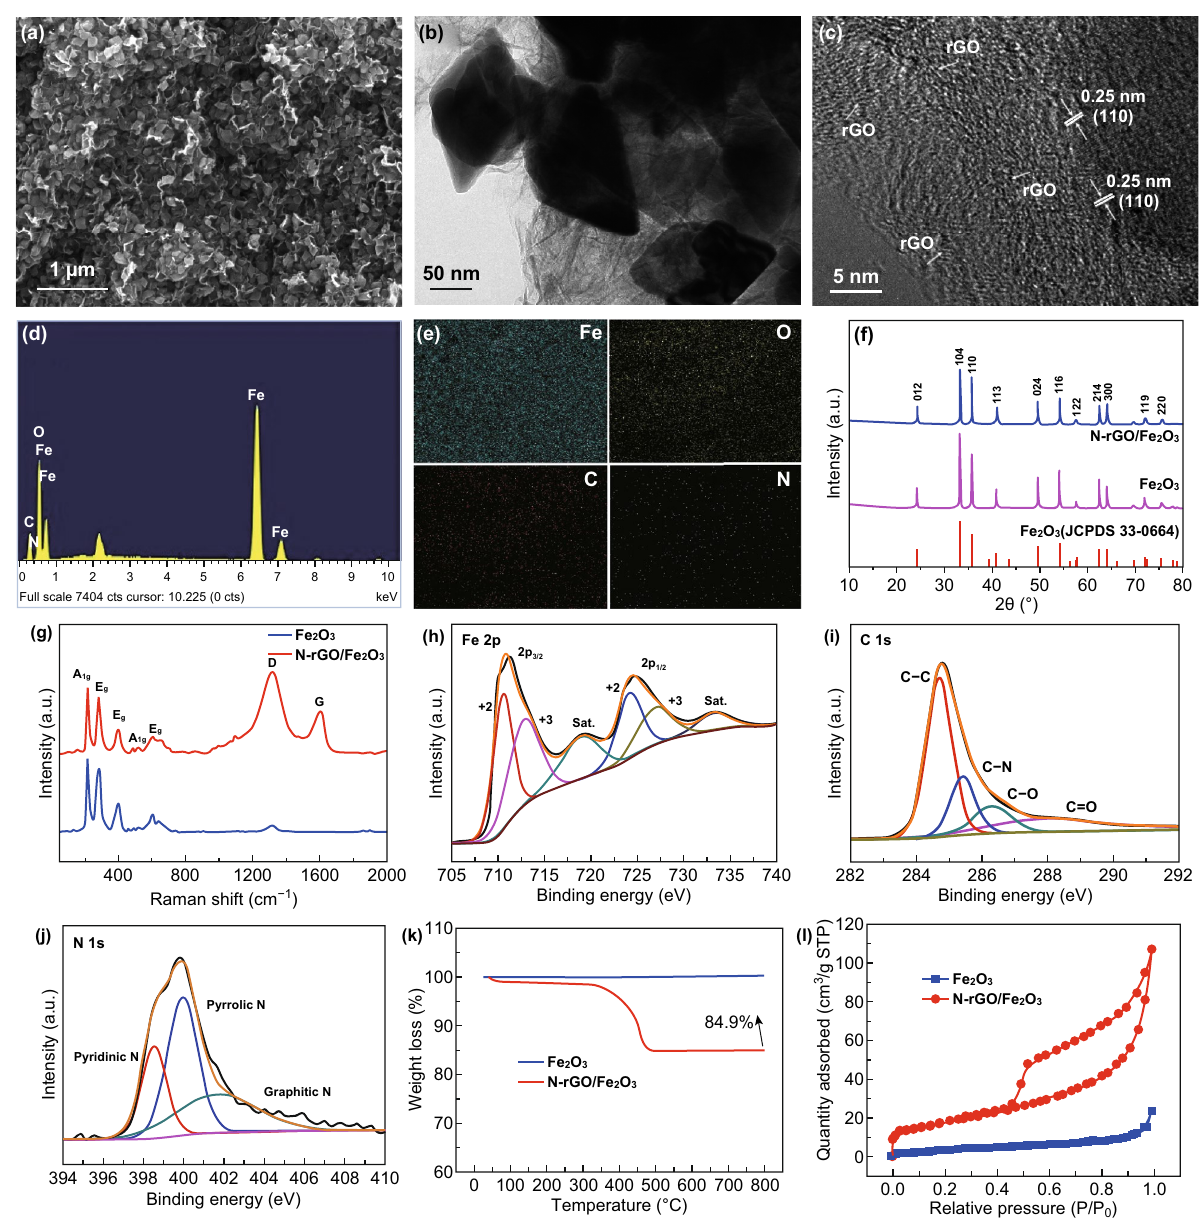
Fig. 6 a FESEM image, b TEM image, c HRTEM image, d EDS spectrum and e corresponding elemental mappings of Fe, O, C and N ele‑